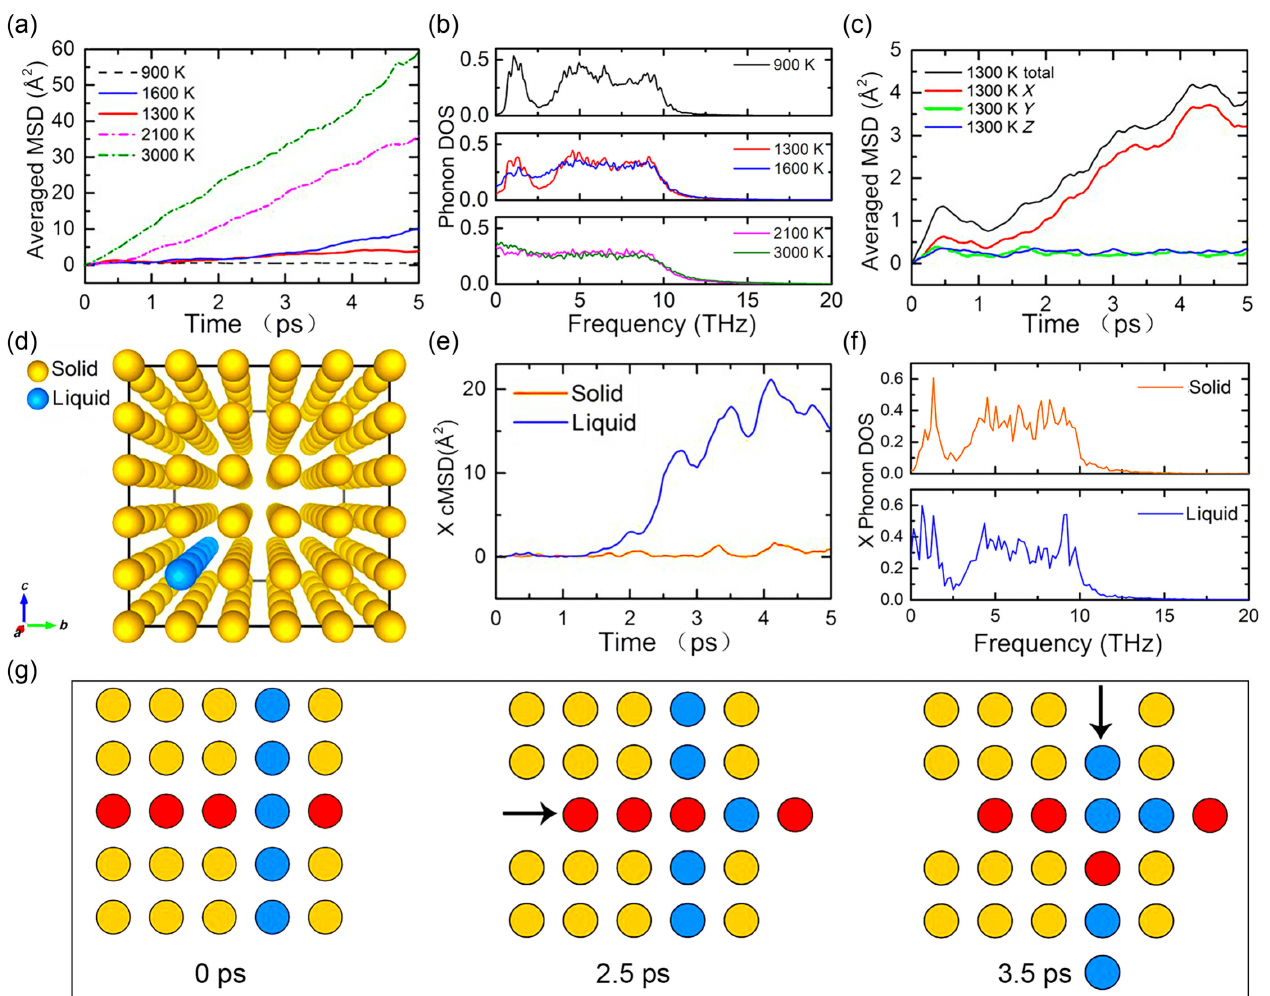
FIG. 1. Behavior of sc Ca at finite temperatures from AIMD simulations in a 125 atom supercell at 50 GPa. (a),(b) The averaged mean- squared displacements (MSD) and phonon DOS of sc Ca at 900, 1300, 1600, 2100, 3000 K (dash line, solid line). (c) The MSD at 1300 K and its various directions. (d) – (f) Representations of two diffusive states in sc Ca, and the difference between their MSDs and DOS along chains (cMSD). (g) Snapshots of chains ’ melting along the h 100 i in sequence at 50 GPa and 1500 K with two different directions on a section of a